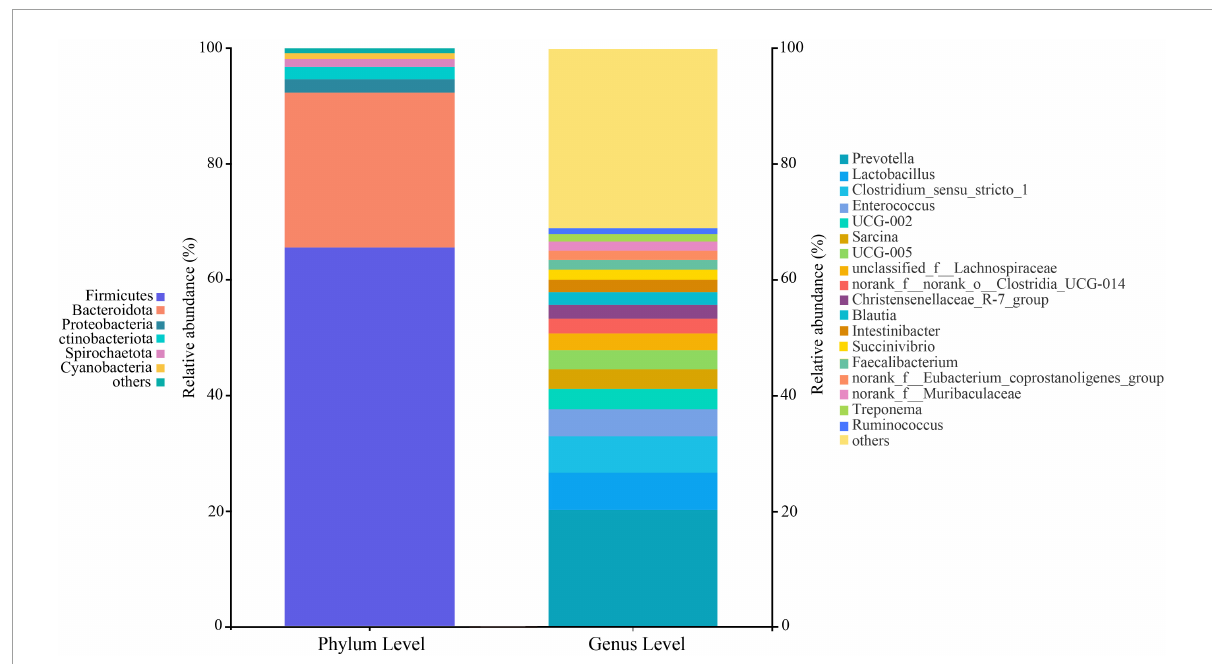
FIGURE2 Composition of the gut microbiota at the phylum and genus levels. All taxa with a relative abundance of less than 1% were classified as “others”.